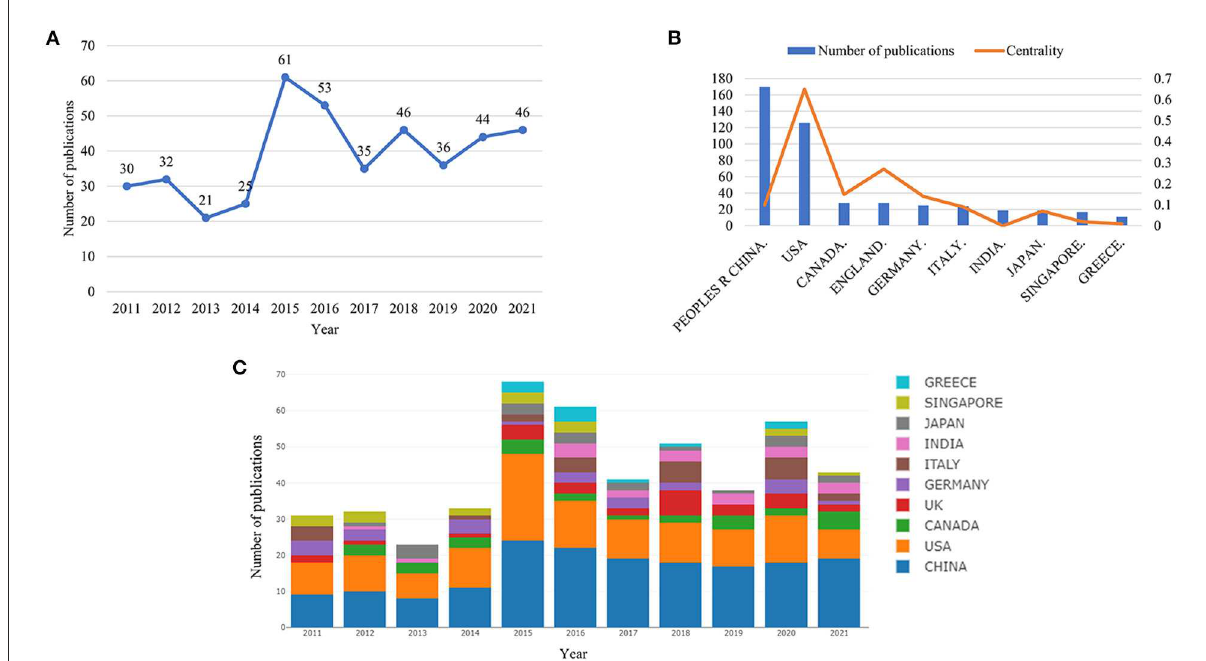
FIGURE1 Trends in the number of publications and analysis of country/regions in hydrogen sulfide in heart preservation research. (A) The annual worldwide publication output. (B) Numbers, centrality for the top 10 countries/region. (C) Number of publications output from the top 10 countries.